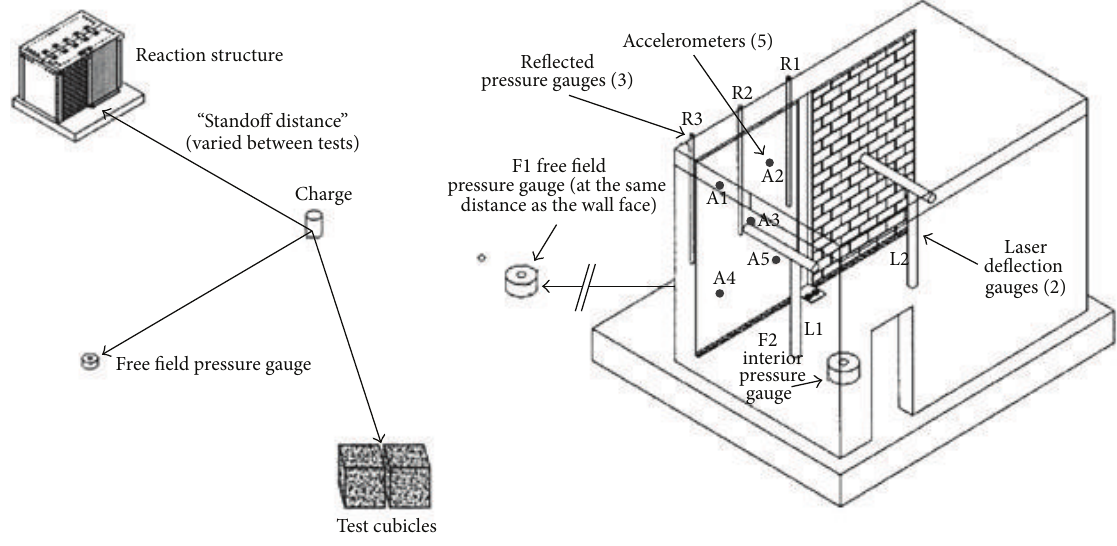
Figure 3: Full-scale masonry wall test setup [8,